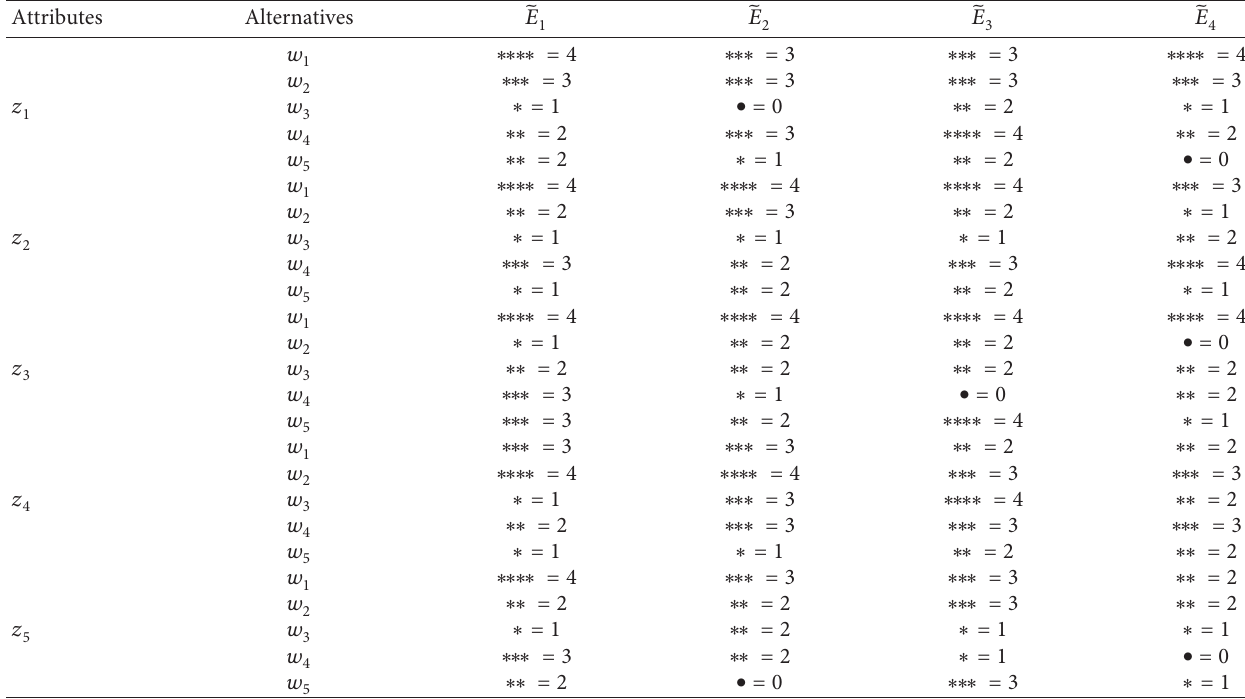
Table 26: Experts’ rating according to